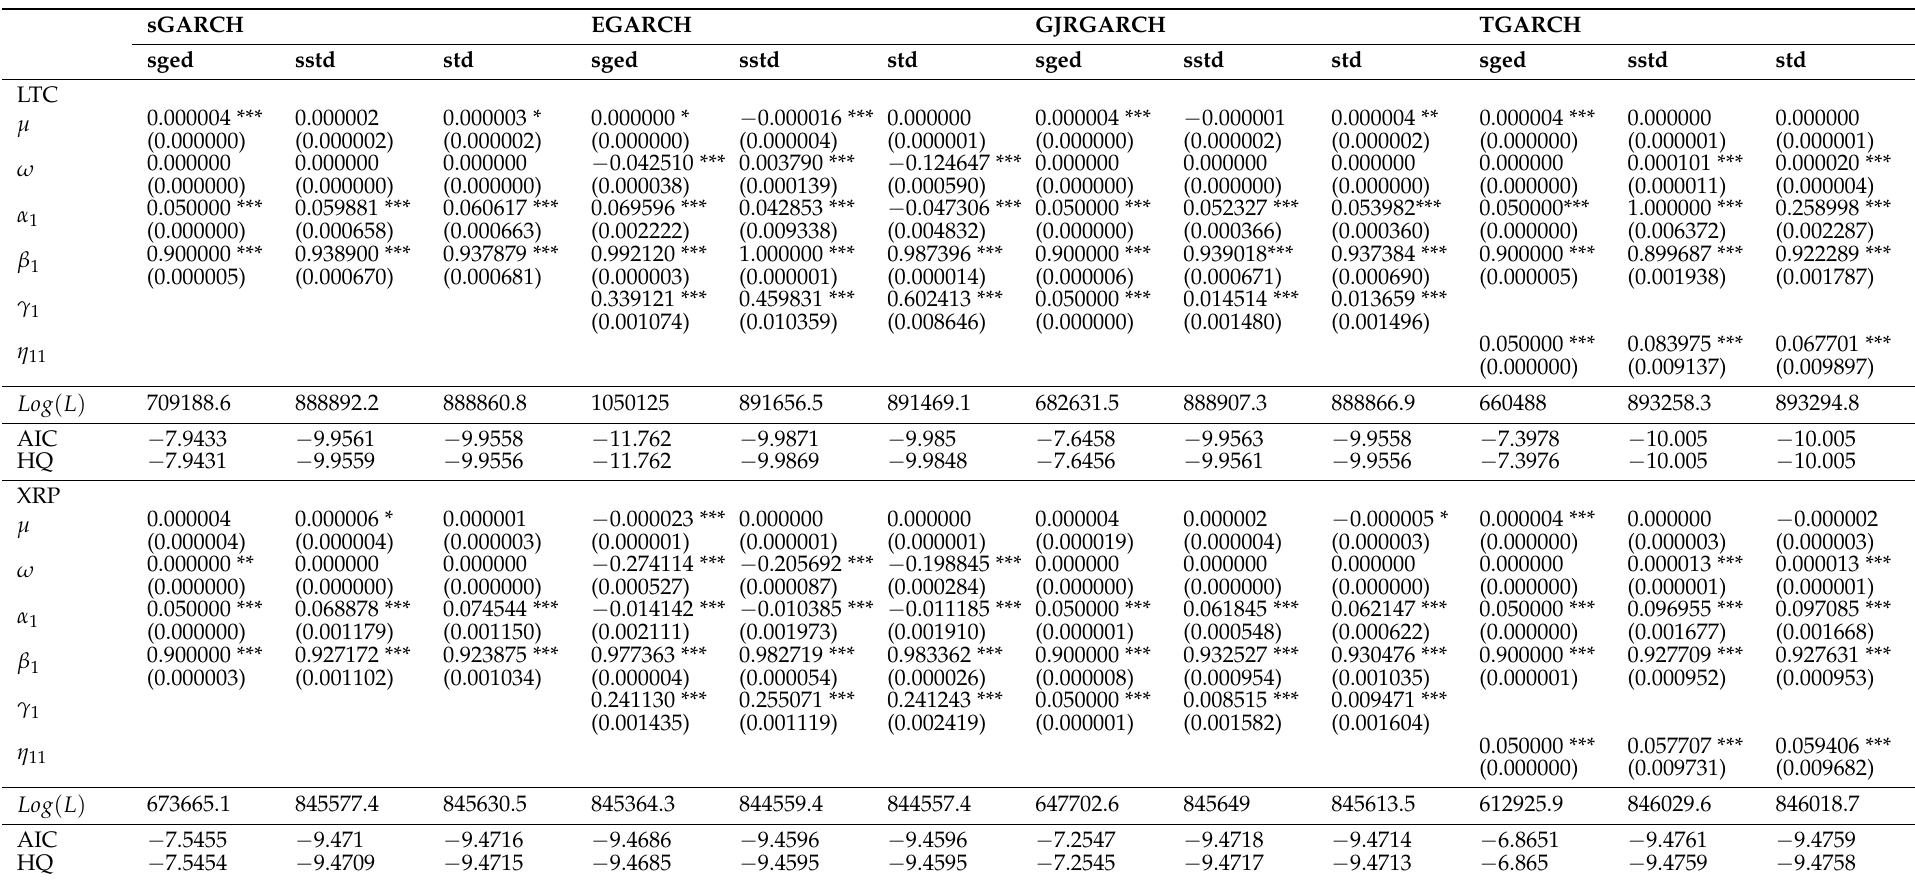
Table 5. Maximum likelihood estimates of the GARCH